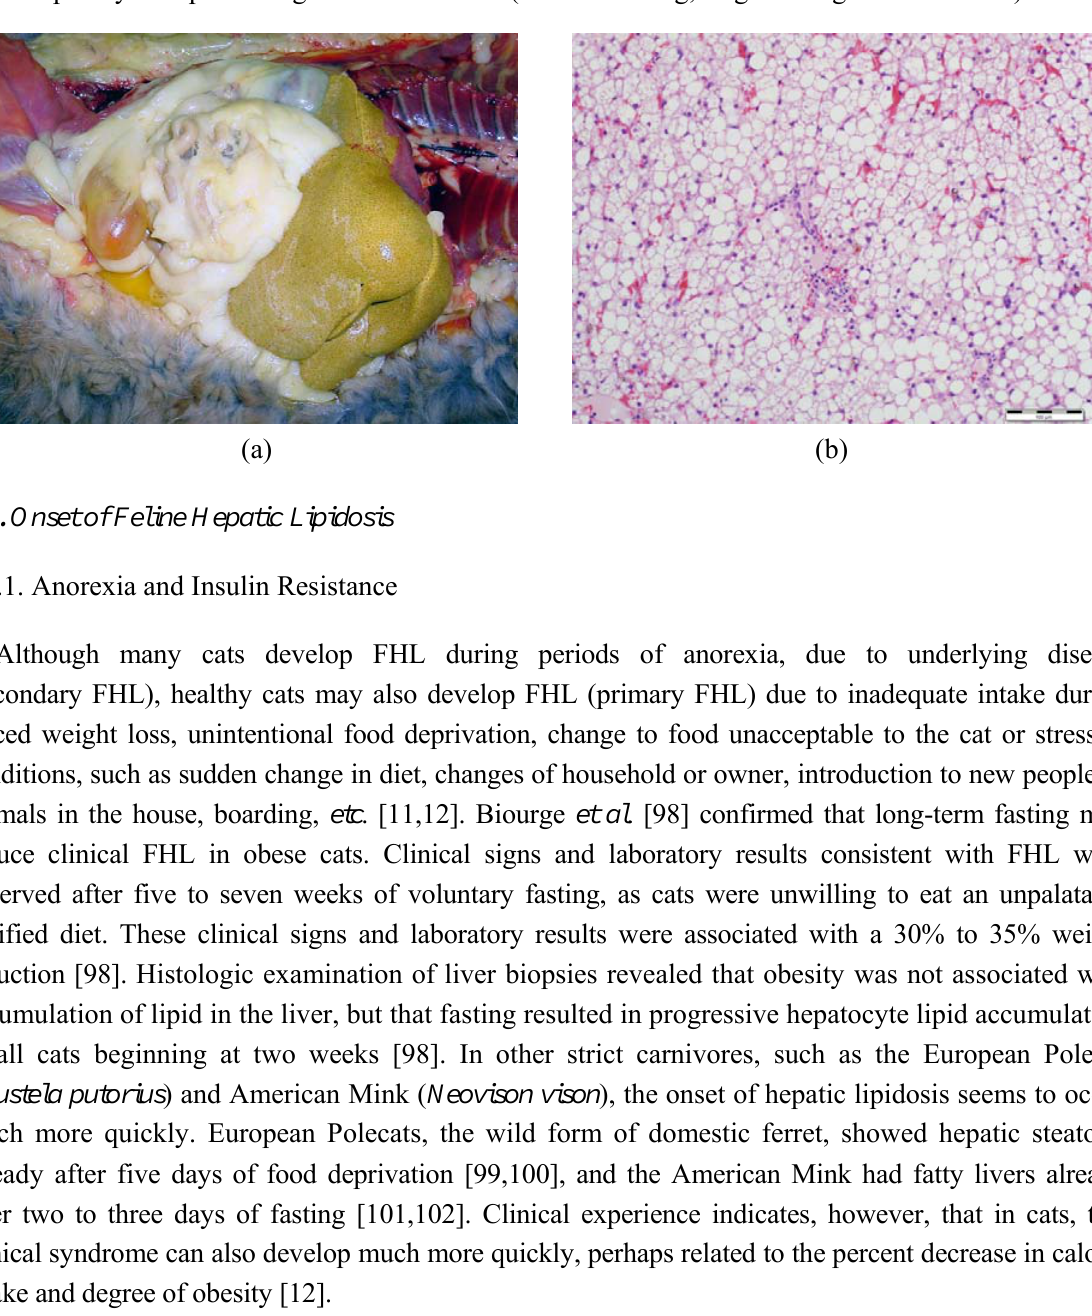
Figure 4. The liver of an obese cat with hepatic lipidosis. ( a ) In situ liver of an obese cat with hepatic lipidosis; note the yellow discoloration and hepatomegaly. ( b ) Liver tissue of an obese cat with hepatic lipidosis, showing diffuse cytoplasmic vacuolization of the hepatocytes representing fat accumulation (H & E staining, original magnification: